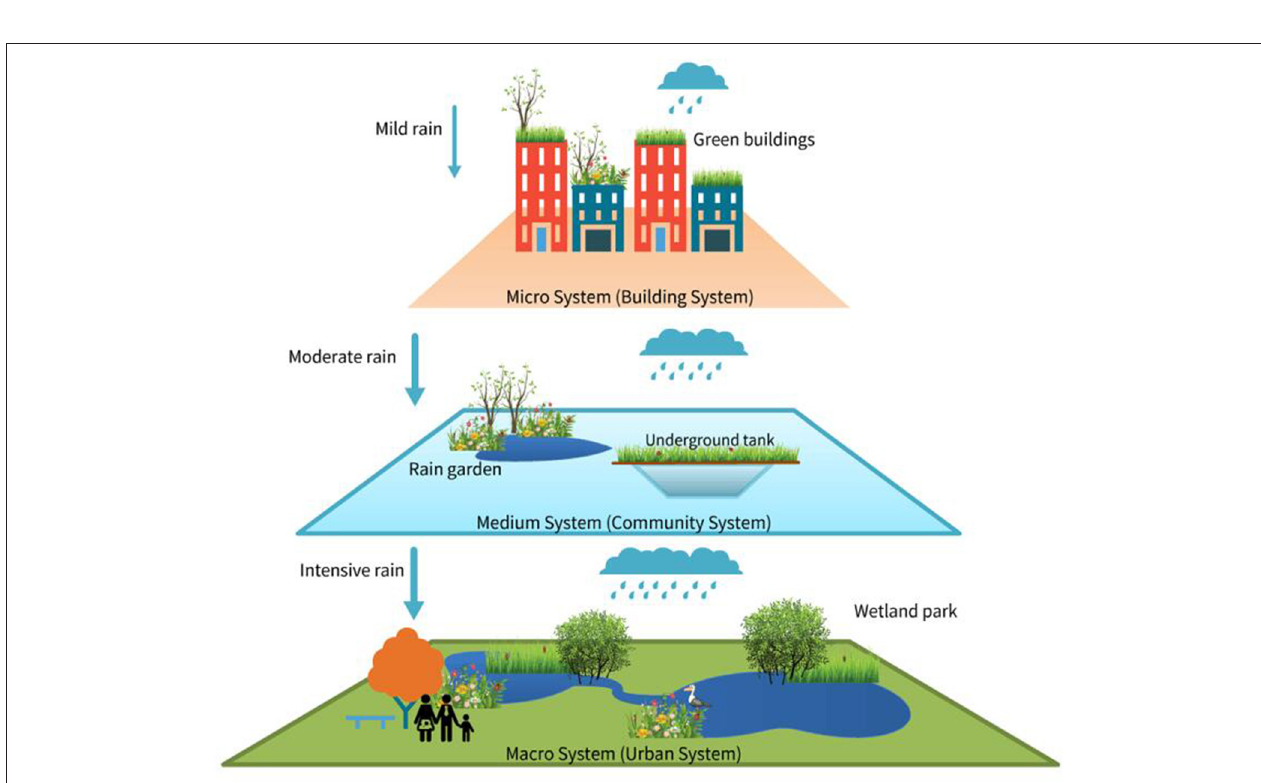
FIGURE 3 | The SCP technical system (Source: